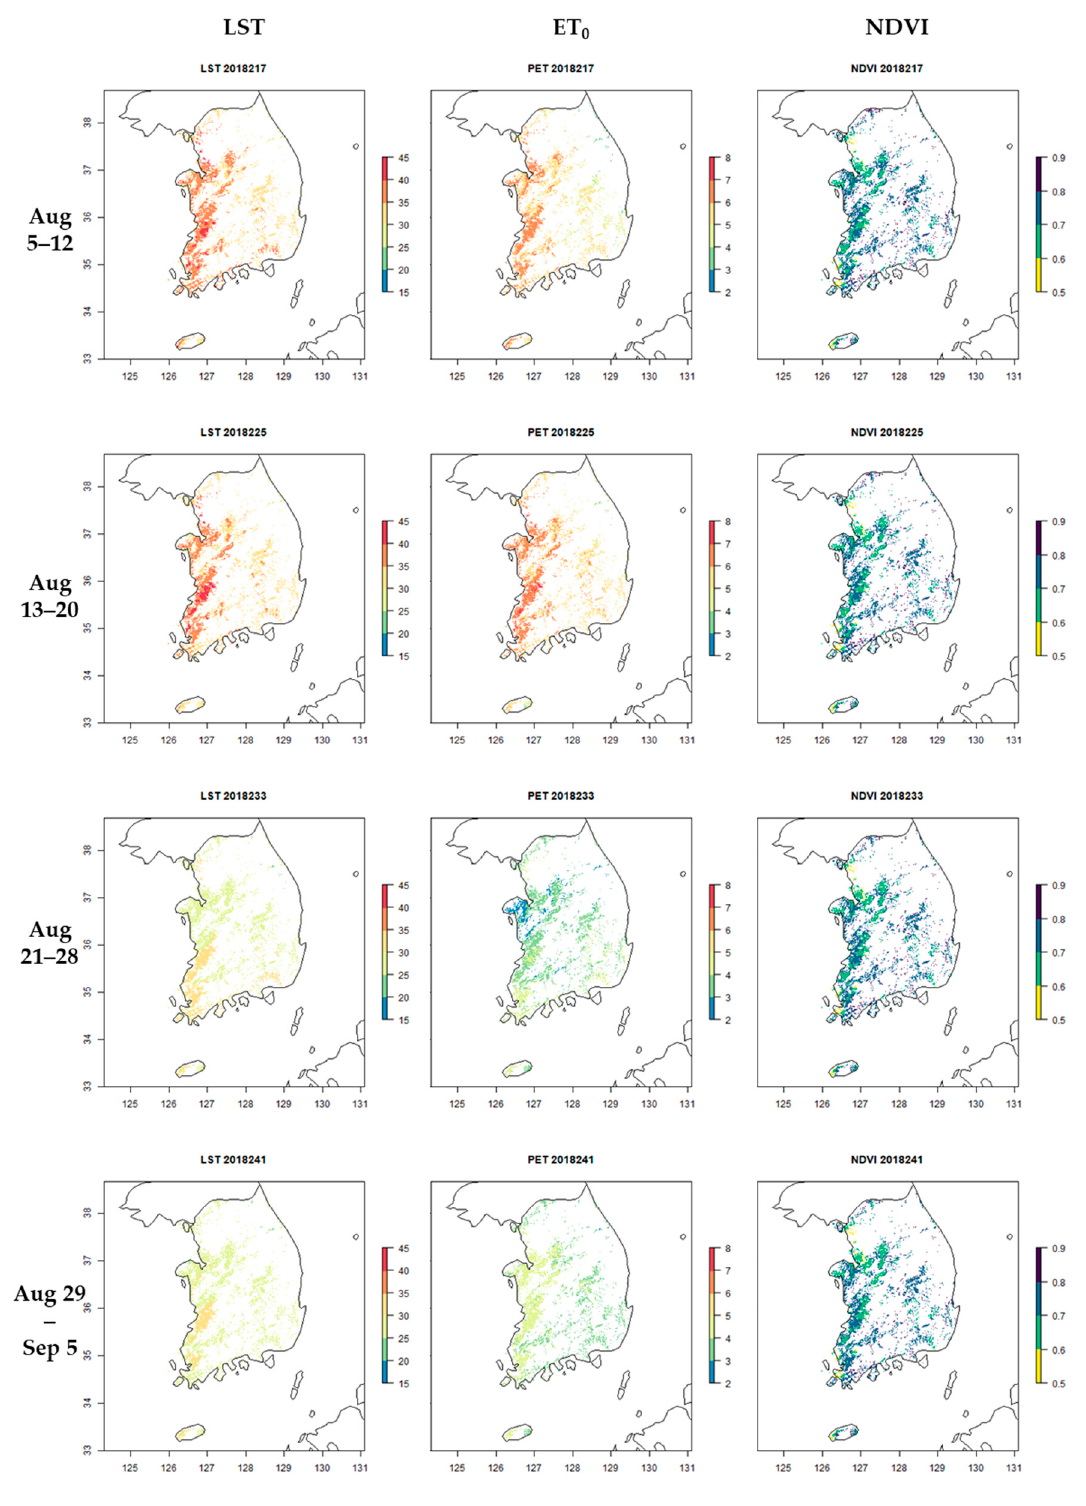
Figure 12. Maps of the land surface temperature (LST), reference evapotranspiration (ET 0 ), and normalized difference vegetation index (NDVI) for croplands in South Korea in July and August 2018.